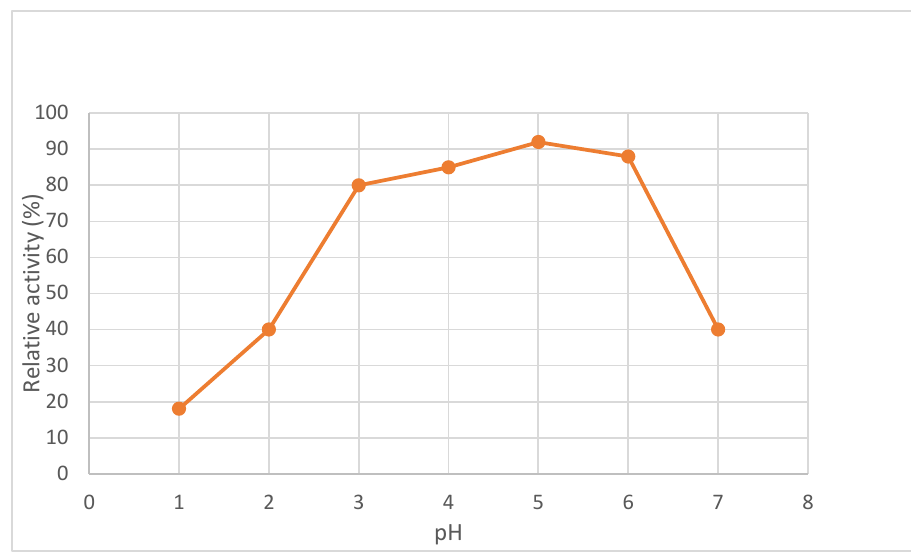
Figure 6. pH stability of alkaline protease.